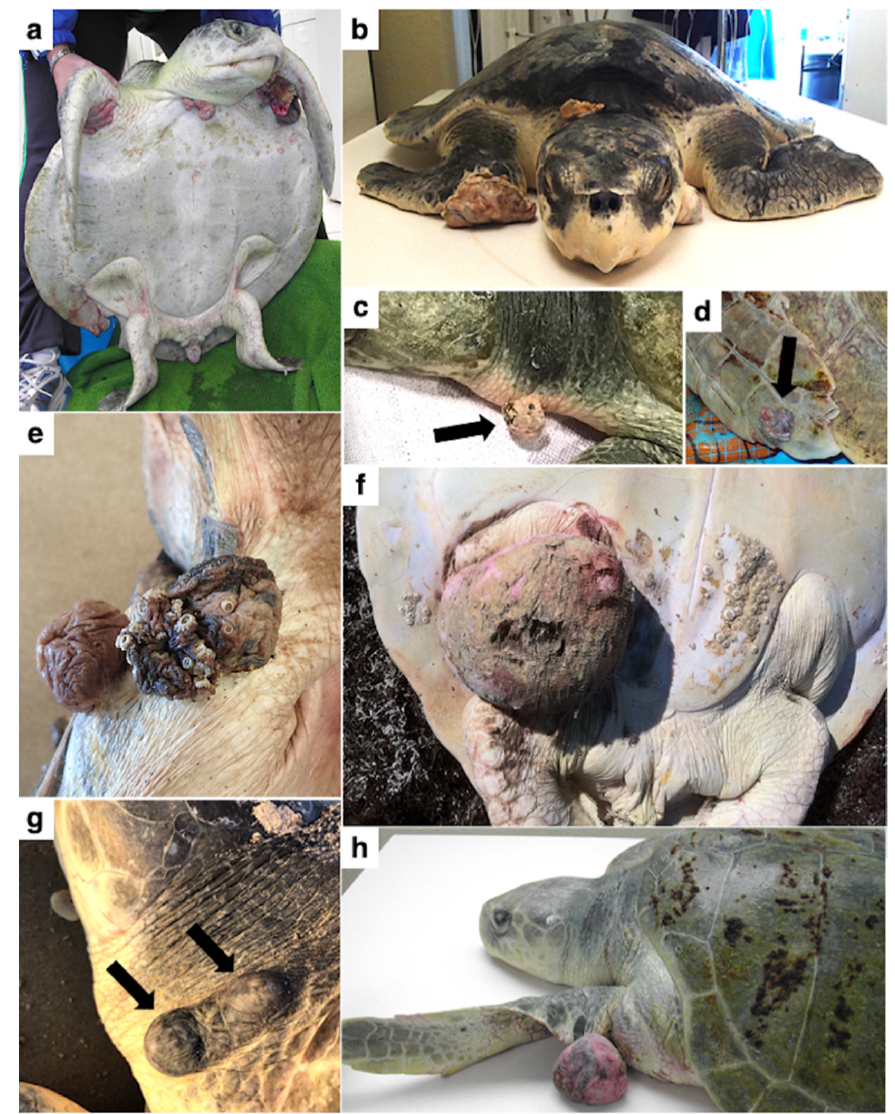
Figure 2. Gross morphology of fibropapillomatosis tumors in afflicted Kemp’s ridley sea turtles ( Lepidochelys kempii ). Masses can develop anywhere on a turtle’s body, and tumor morphology varies from flat plaques, to verrucous, arborizing masses ( A – E ), to smooth polypoid masses ( F – H ).